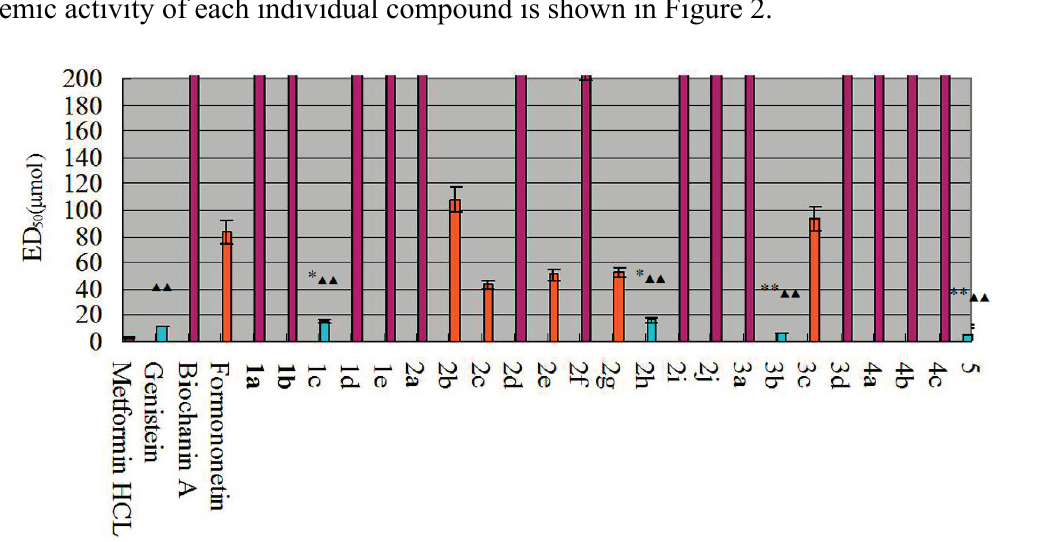
Figure 2. Hypoglycemic activity of the compounds. The differences between these compounds and genistein were statistically significant (denoted by “*” or “**” for p < 0.05 or p < 0.01, respectively). The differences between these compounds and metformin hydrochloride were statistically significant (denoted by “ ▲ ” or “ ▲▲ ” for p < 0.05 or p < 0.01,